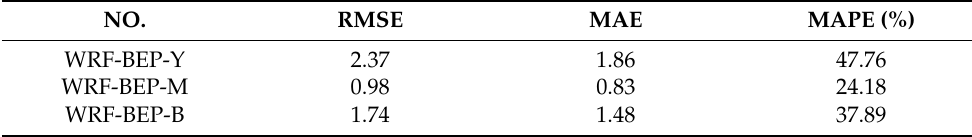
Figure 2. Wind speed time history of simulations and observations. Table 2. Results of Evaluation Metrics for Three PBL Schemes (24 samples).